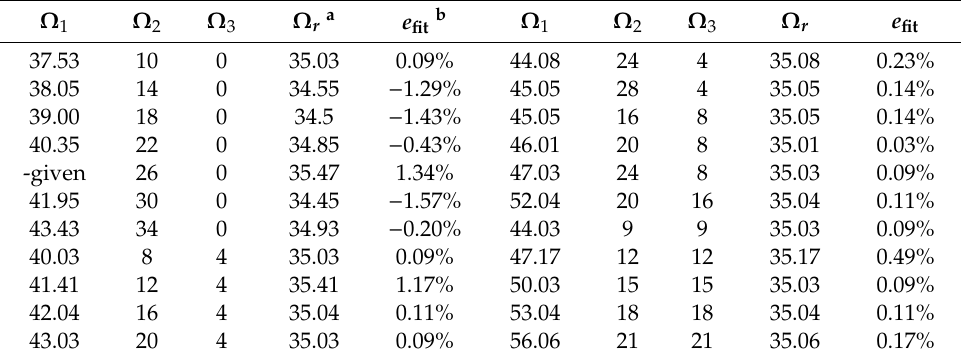
Table 2. Combined principal stresses and verification data